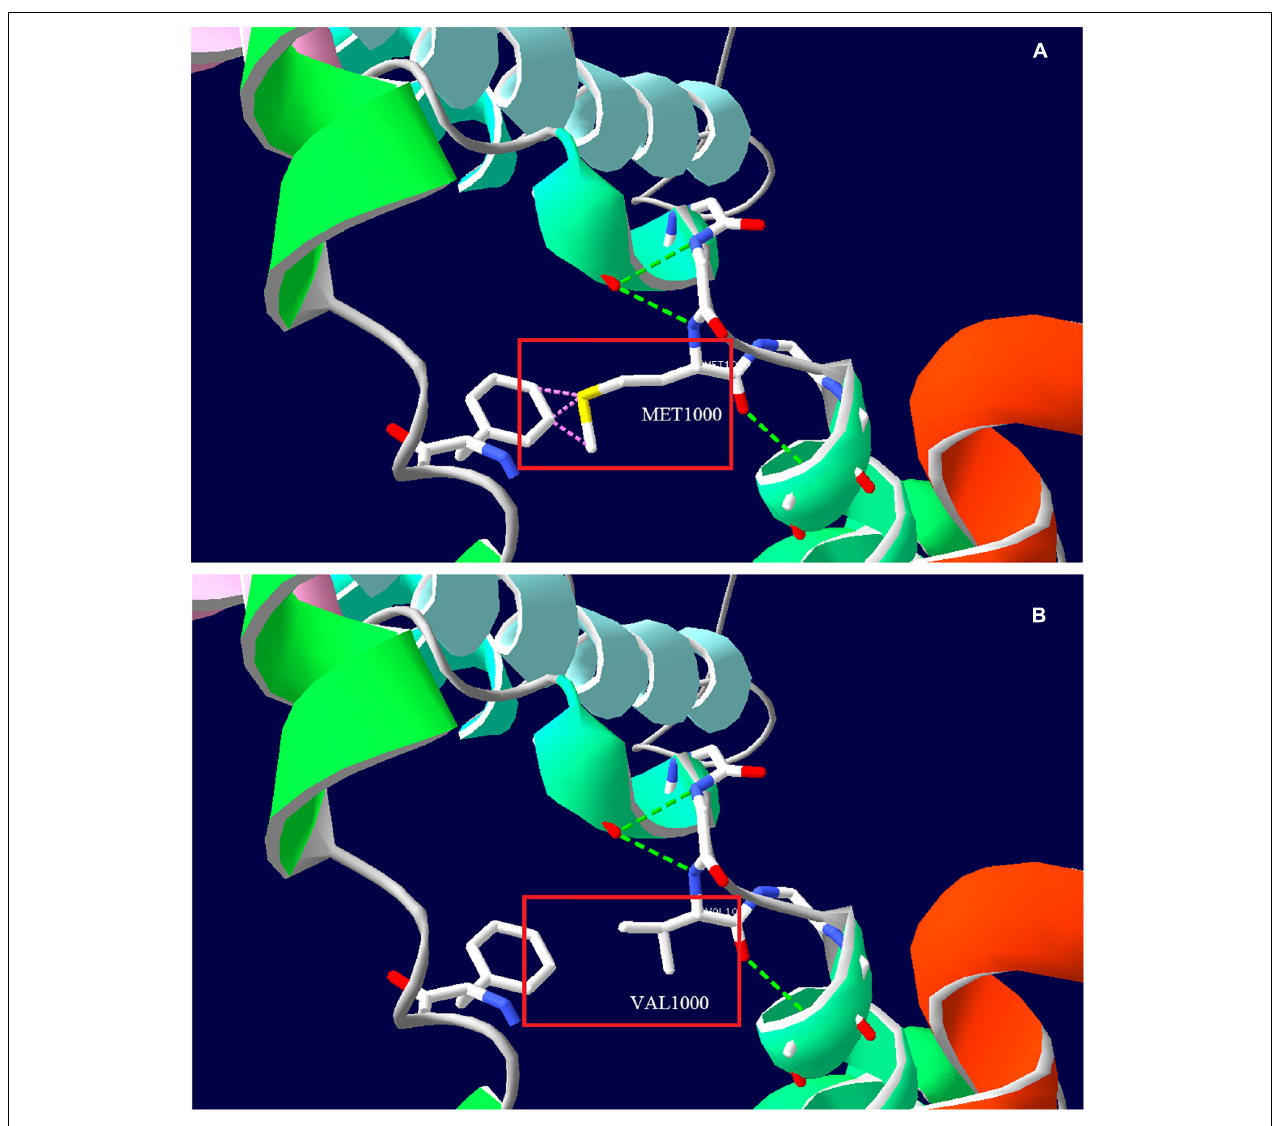
FIGURE 3 | Three-dimensional structure prediction model of TRPM7 protein by SWISS-MODEL and Swiss-Pdb Viewer. (A) Amino acid side chain structure of the wild type (Met1000); (B) Amino acid side chain structure of the mutant type (Val1000). The pink dotted line indicates that the wild type may collide with the adjacent benzene ring (Phe1096), and there is no collision after mutation, the green dotted line indicates the hydrogen